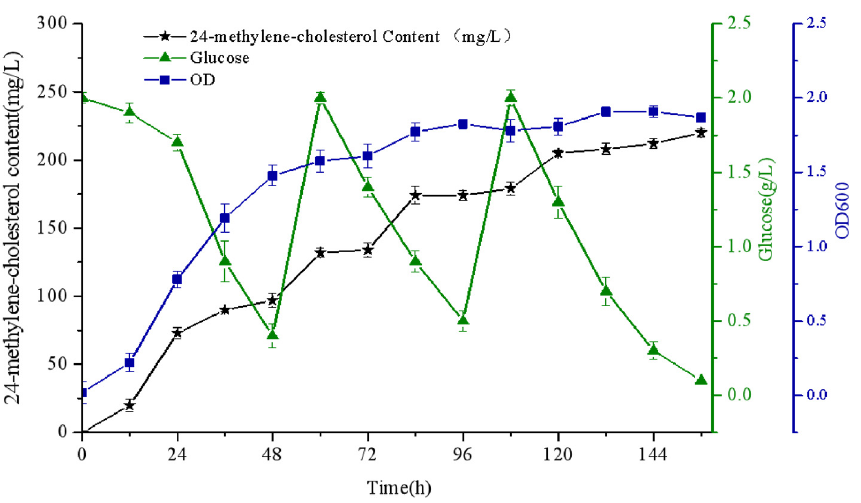
Figure 5 . Real ‐ time PCR analysis of XlDHCR7 in strains YS11 and YS12, with different Figure 5. Real-time PCR analysis of XlDHCR7 in strains YS11 and YS12, with different 24-methylene- 24 ‐ methylene ‐ cholesterol yields: ( A ) YS12 has 1.55 ‐ fold higher mRNA levels of XlDHCR7 com ‐ cholesterol yields: ( A ) YS12 has 1.55-fold higher mRNA levels of XlDHCR7 compared to YS11. pared to YS11. ( B ) 24 ‐ Methylene ‐ cholesterol content in the strains with heterologous expression of ( B ) 24-Methylene-cholesterol content in the strains with heterologous expression of XlDHCR7— YS12 compared with YS11. An additional copy of XlDHCR7 increased 24-methylene-cholesterol production by 23%. Error bars represent standard deviations (n = 3). Asterisks indicate significant differences compared to YS11; Student’s t -test, * p < 0.05.